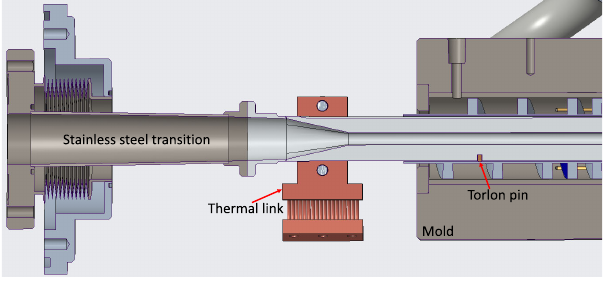
FIG. 18. Features of the HSCU beam chamber design showing the transition from room temperature, location of the thermal link outside of the magnet/mold structure, and the torlon pins used as a low heat leak support between the chamber and the magnet.